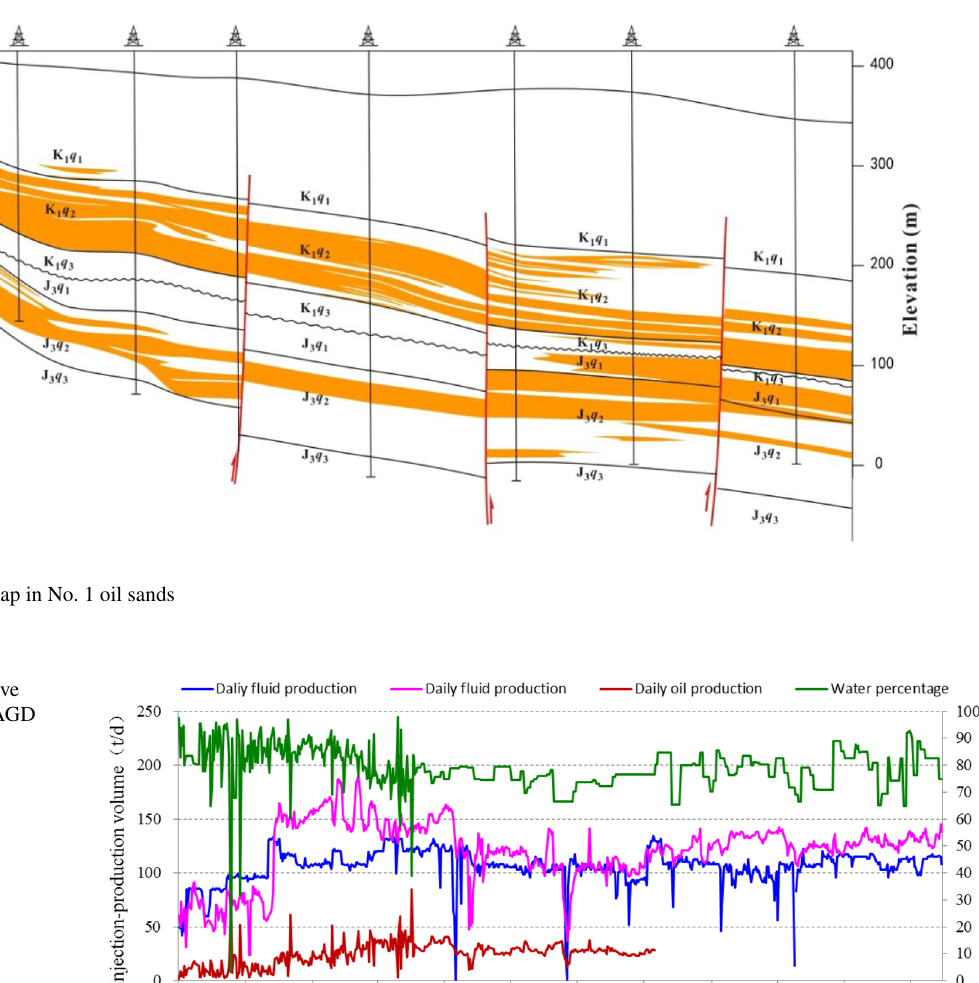
Fig. 9 Buried depth of single hole in No. 3 oil sands